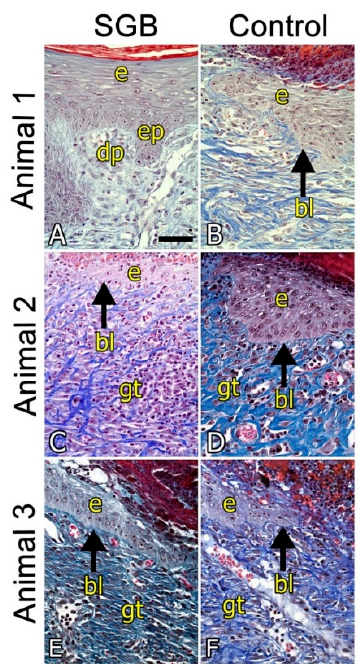
Figure 5. Histological study after four weeks of wound dressing implantation. Amplification of photomicrographs showed in Figure 4. Epidermal epithelial lining (e), basal lamina (bl and arrow), epidermal papillae (ep), dermal papillae (dp) and granular connective tissue (gt) are shown. Bar 50 µm.